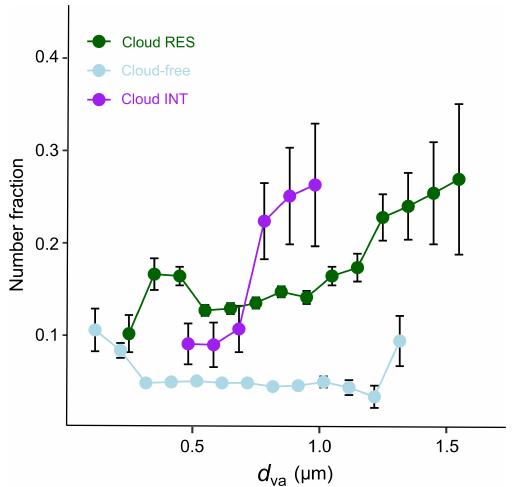
Figure 2. Size-dependent Nfs of oxalate-containing particles rela- tive to all the detected cloud-free, cloud RES, and cloud INT parti-